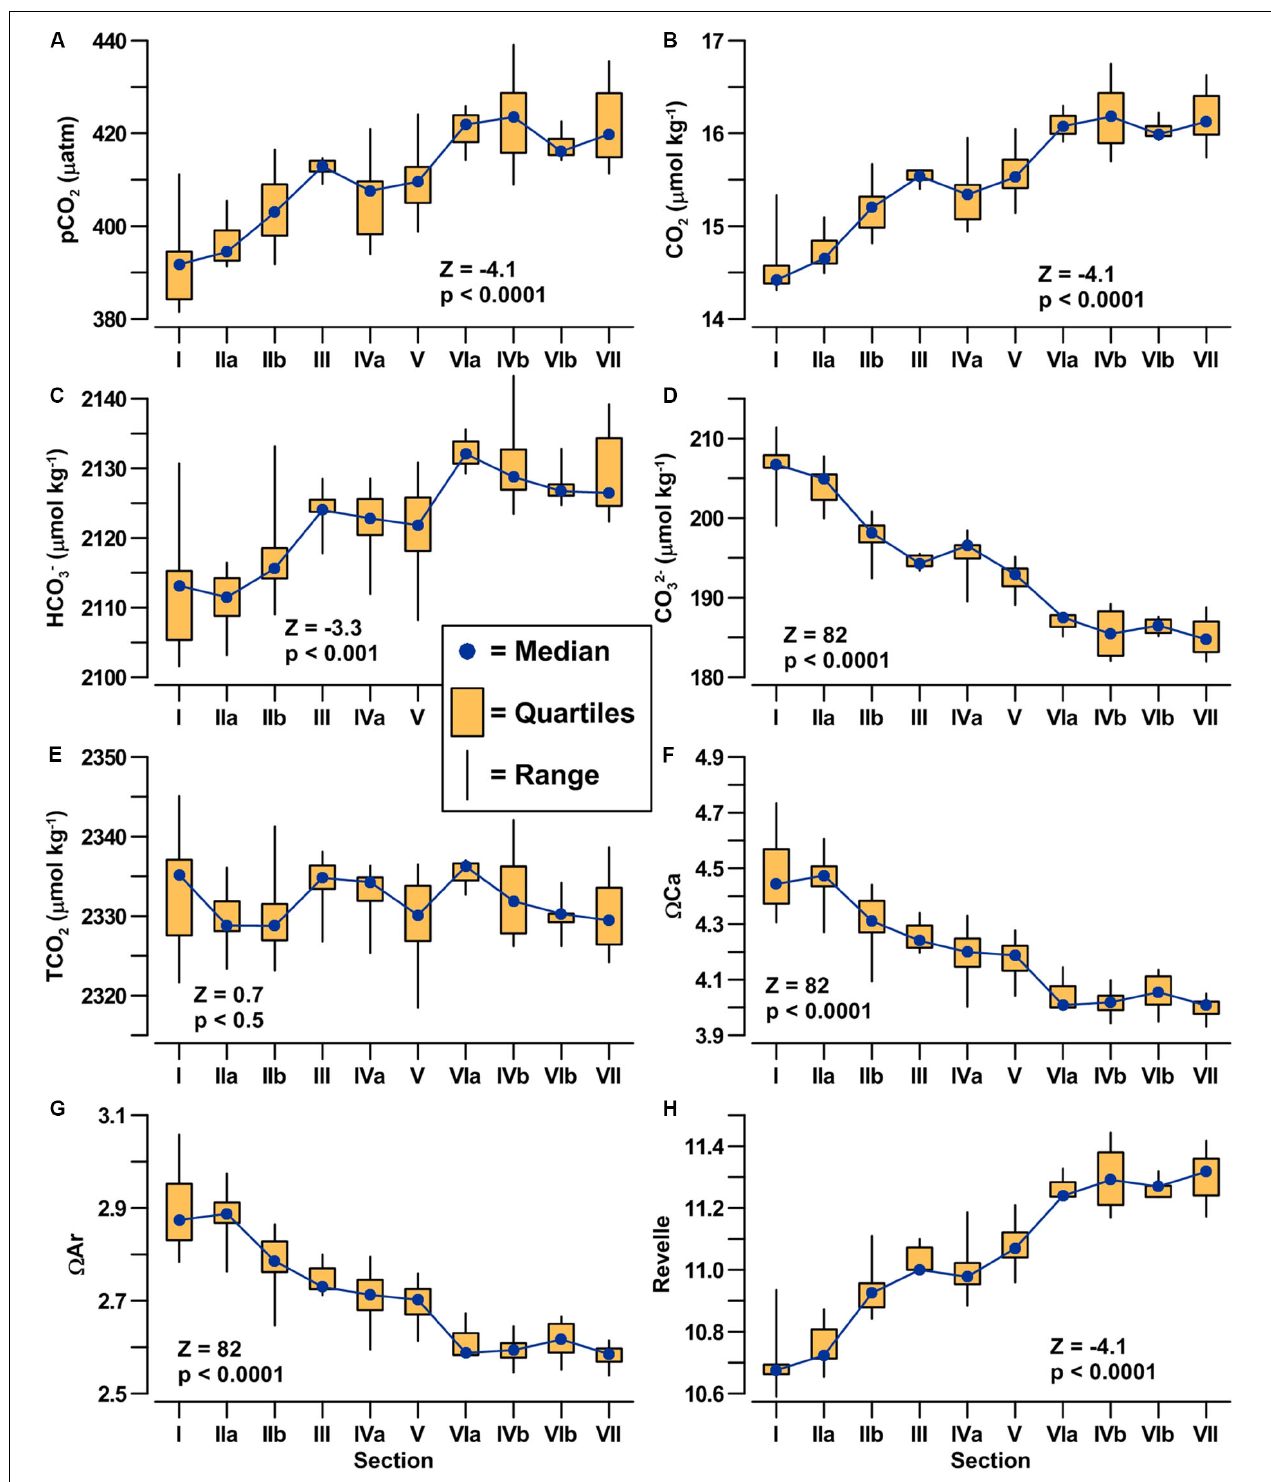
FIGURE 4 | Box-Whisker plots (median, quartiles, range of values) of IW properties (in the subregions defined in Figure 1 . The significance of the changes between the subregions I and VII (Mann–Whitney U test; Z value, probability) is also shown. (A) pCO2, (B) CO 2 , (C) HCO 3 − , (D) CO 32 − , (E) TCO 2 , (F) saturation state of calcite ( (cid:127) Ca), (G ) saturation state of aragonite ( (cid:127) Ar), and (H) Revelle factor.